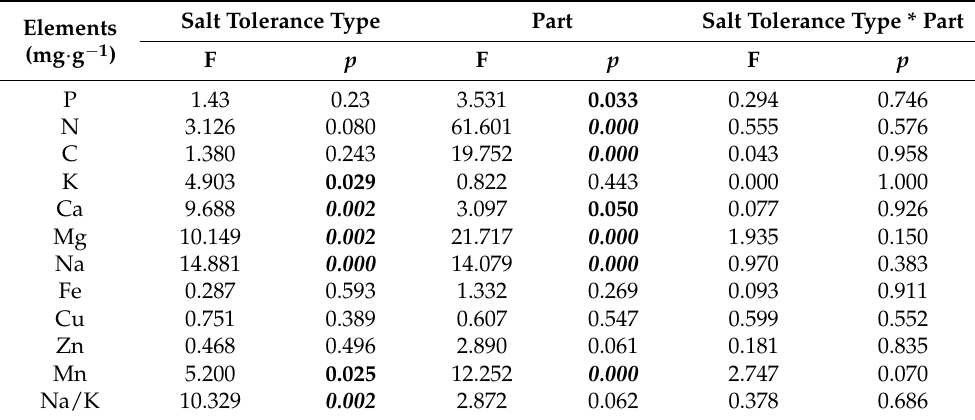
Table 2. Two-way ANOVA was performed to assess the effects of salt tolerance type, plant tissue parts and their connection to element concentrations.